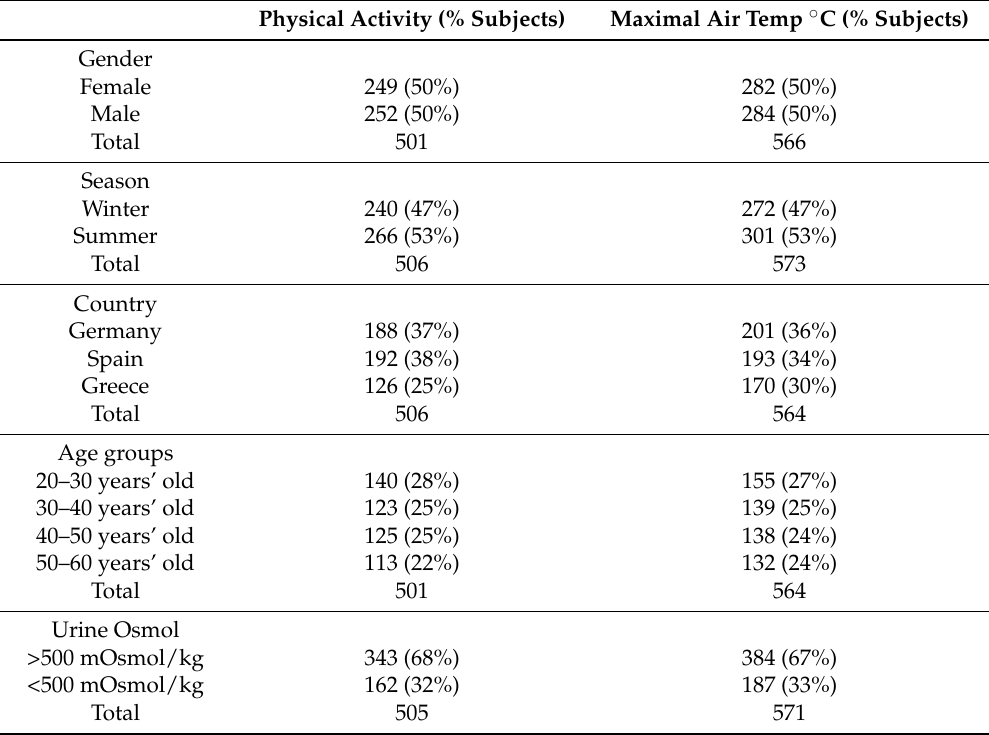
Table 2. Sample size in categorical variables and percentage in each